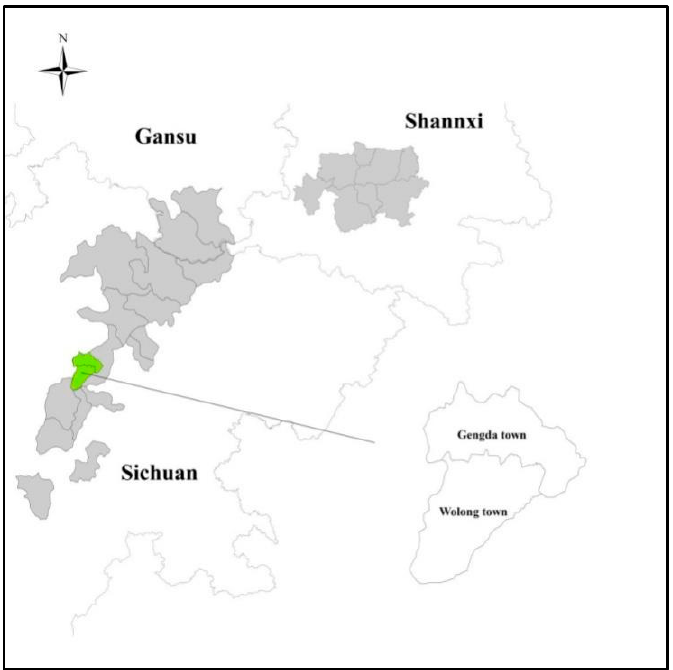
Figure 2. Map of the research area.